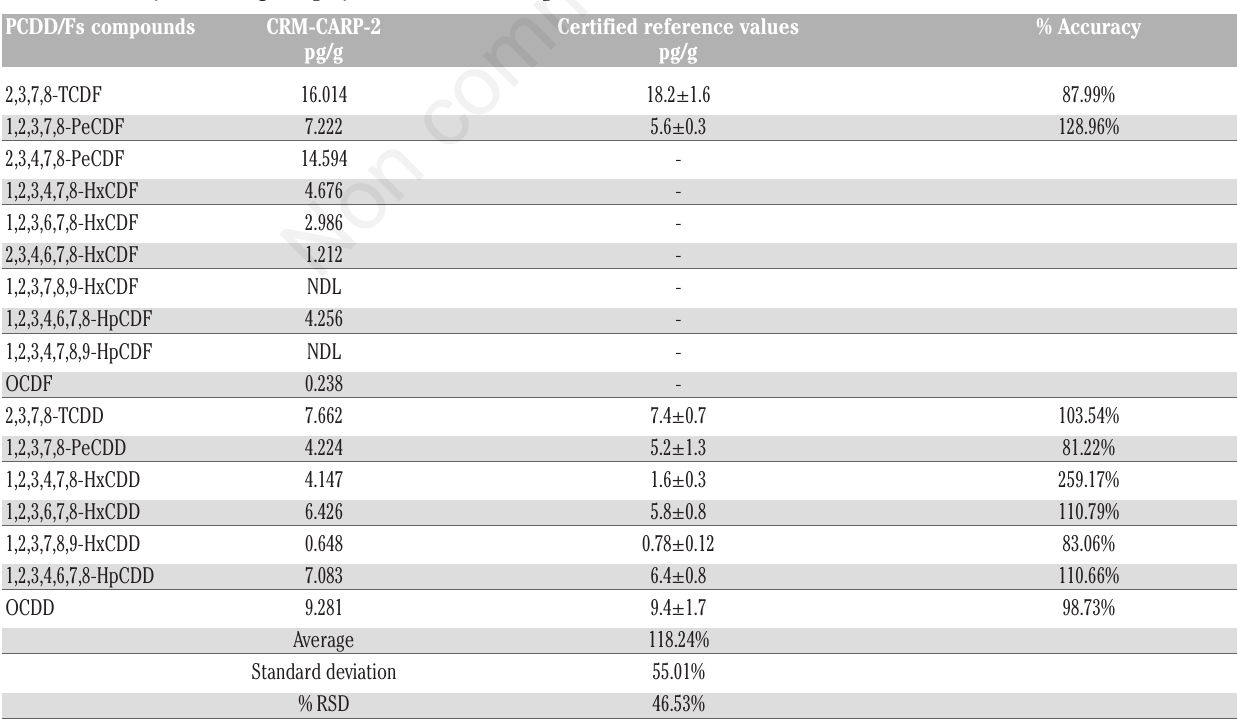
Table 2. Accuracy of the targeted polychlorinated dibenzo- p -dioxins/furans for the CRM-CARP-2. PCDD/Fs compounds